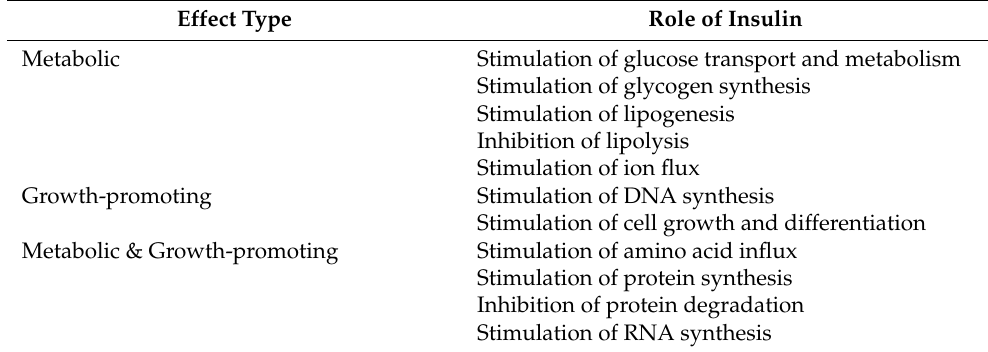
Table 2. Functions of insulin in human body [21].